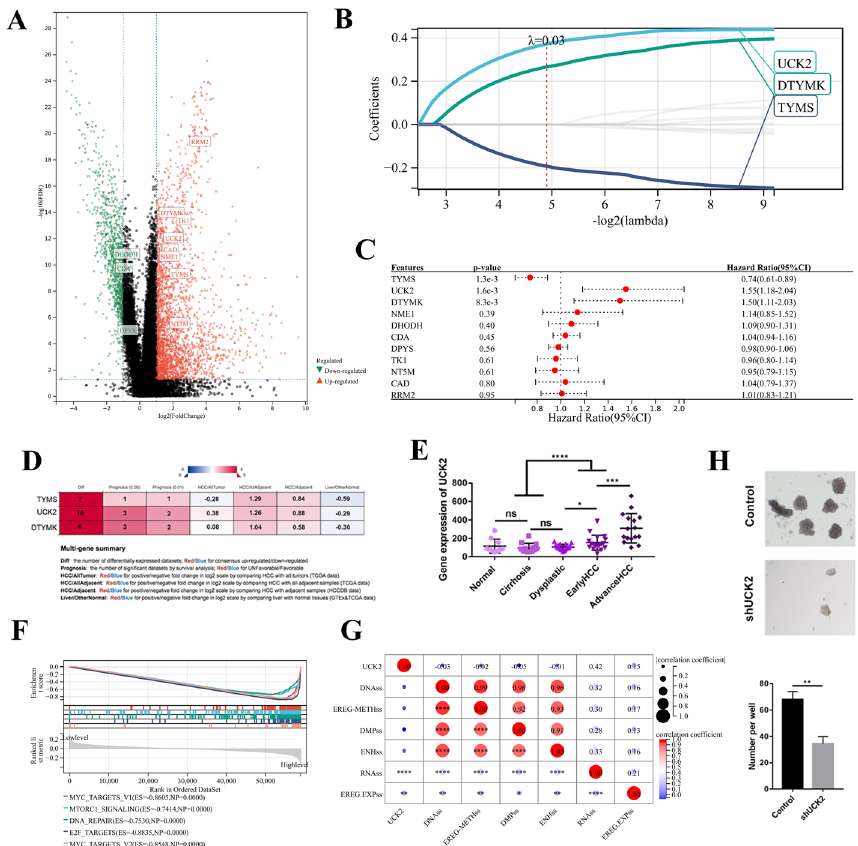
Fig. 1 UCK2 was upregulated in HCC and involved in tumour stemness. A Volcano plot for different expression genes between tumour and adjacent tissues. B , C Lasso–Cox regression analysis filtered genes significantly associated with the prognosis of HCC. D Integrative molecular database of HCC (HCCDB) database was used to examine the role of TYMS, UCK2 and DTYMK in HCC. E The expression of UCK2 in different stage during HCC development, data derived from GEO6764. F GSEA analysis revealed the signalling pathways related to UCK2. G Correlation of UCK2 and stemness features. H 3D sphere formation for the indicated cell lines, * p < 0.05; ** p < 0.01; *** p <